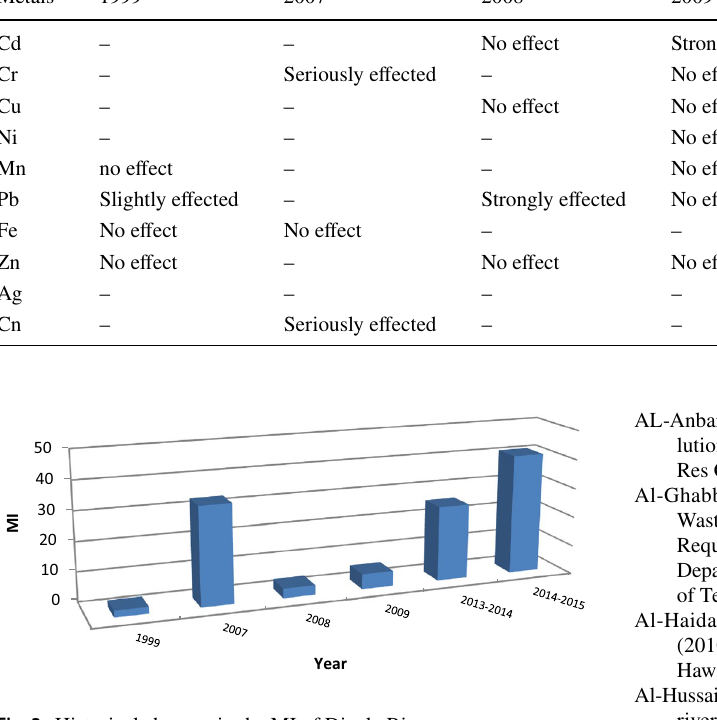
Fig. 3 Historical changes in the MI of Diyala